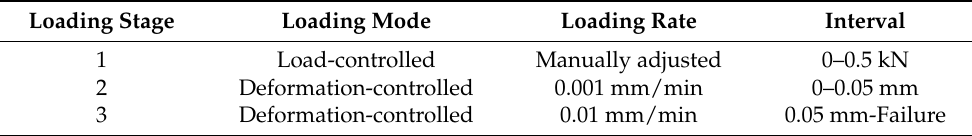
Table 4. Proposed loading procedure for direct uniaxial tensile tests on concrete